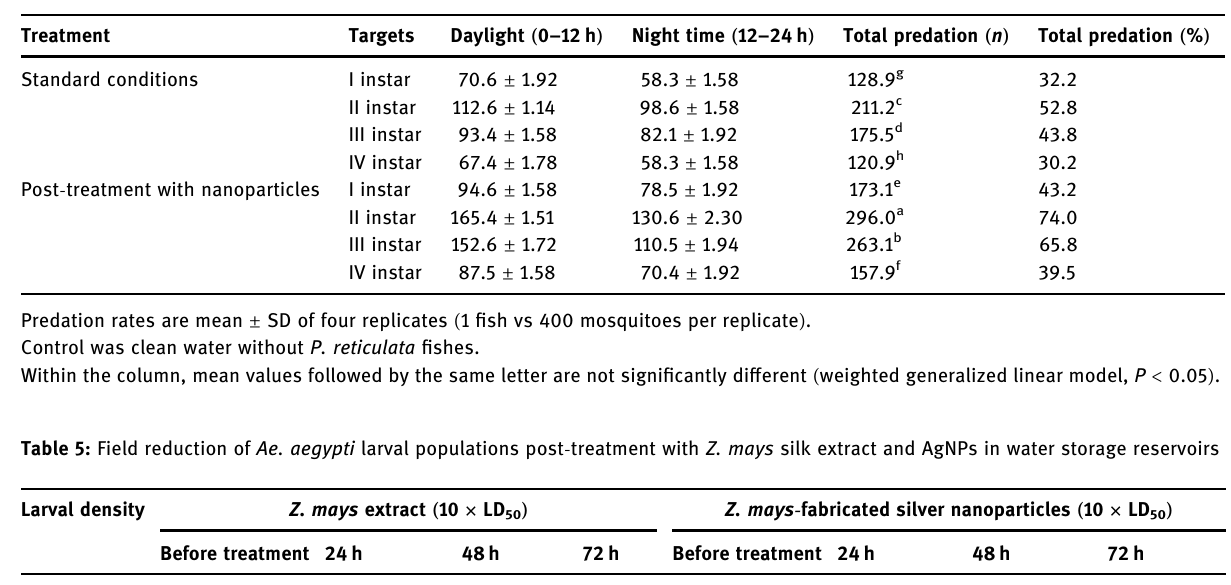
Table 4: Predatory e ffi cacy of Poecillia reticulta against dengue vector, Ae. aegypti post - treatment with 1 ppm of AgNPs ( i.e., 1/3 of the LC 50